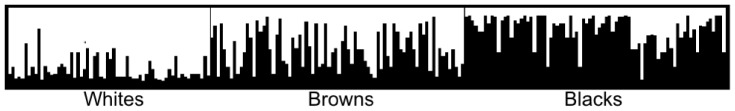
Graph of the individual value of the “Pigmentation Index” (PI) estimated using the Structure software, on the basis of the proportion of belonging to two clusters.Each thin vertical line represents one individual (243 in total). Vertical black lines separate the individuals into three different self-categorized skin color, identified by the labels on the bottom. Ten Structure runs were performed with a burn-in of 100,000 iterations and run length of 2,000,000 iterations.